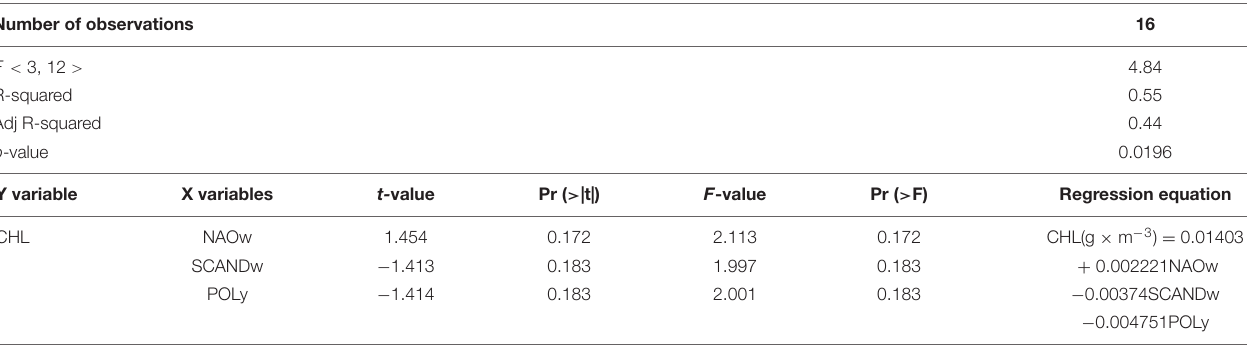
FIGURE 3 | Plots of residuals vs. predicted values for chlorophyll a (A) and plankton primary production (B) models. TABLE 3 | Results of stepwise multiple regression analysis between the concentration of chlorophyll a (CHL, variable Y, predictand) and values of climatic indices (variables X,